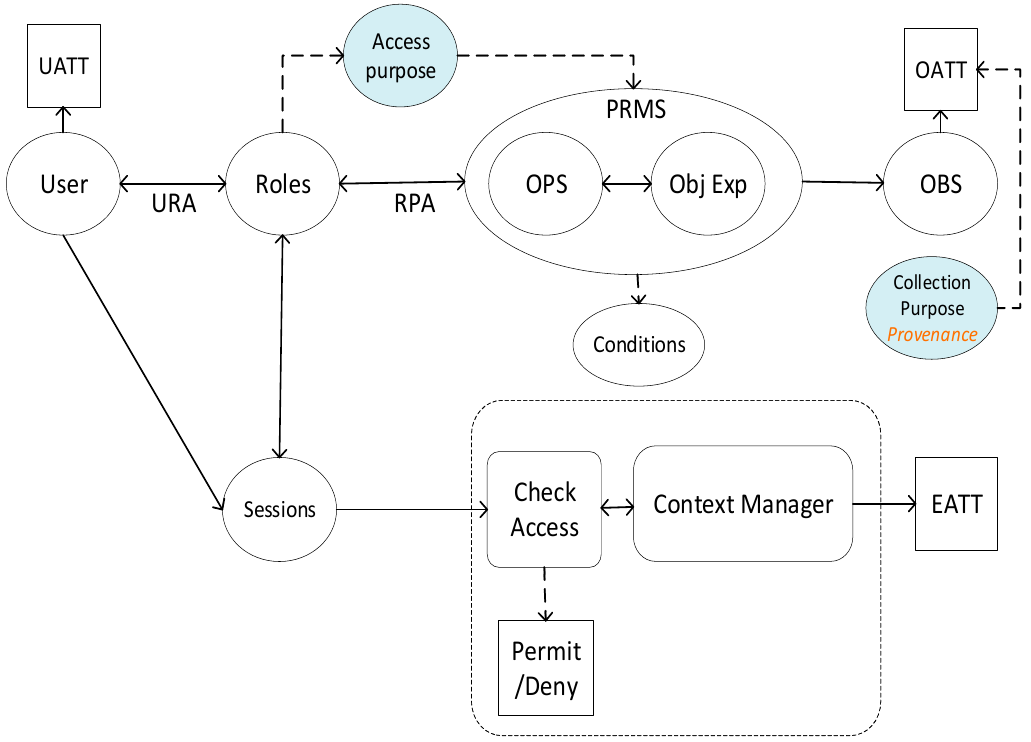
Figure 5. Provenance-enabled AERBAC.